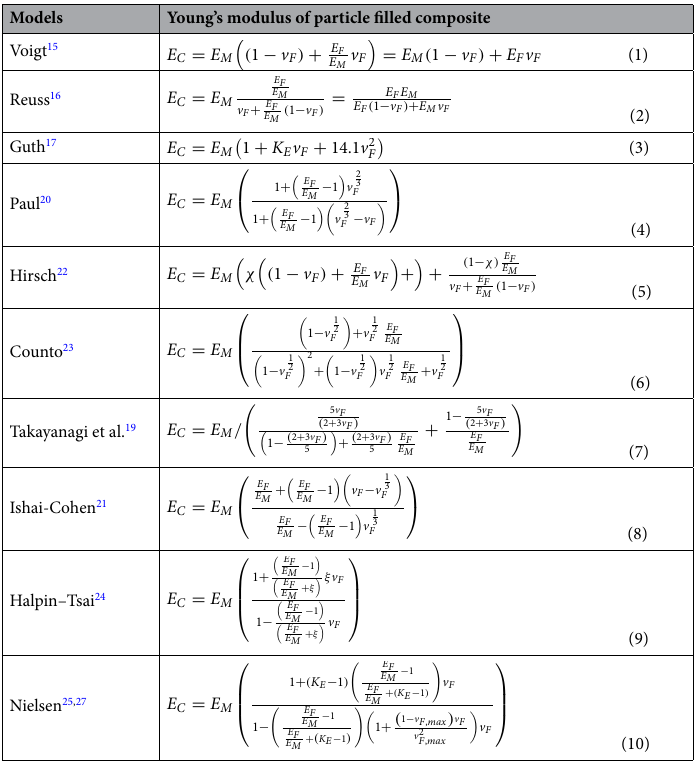
Table 1. Summary of two-phase models to predict Young’s moduli of particulate composites. Moduli of matrix